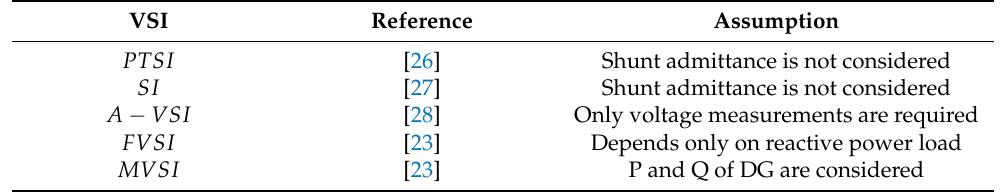
Table 2. VSI applied in microgrids.